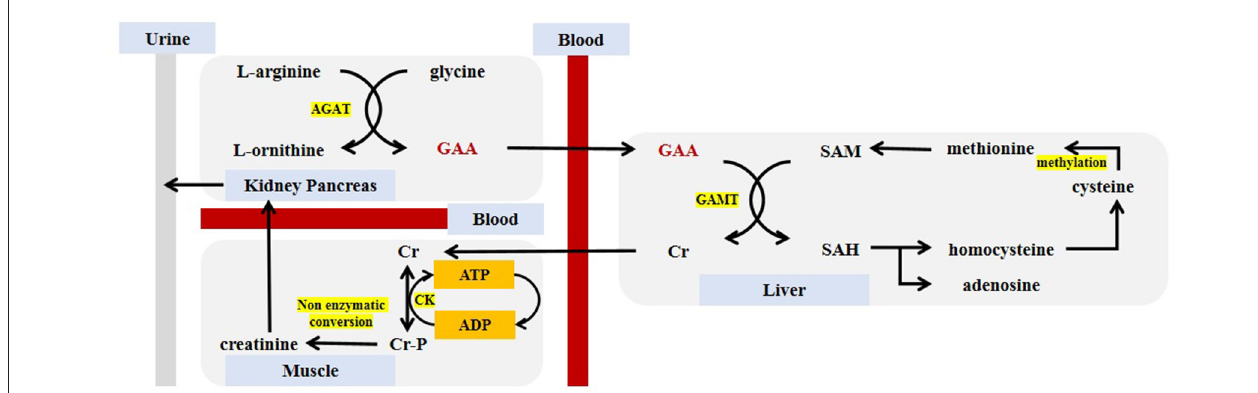
FIGURE 2 | Guanidinoacetic acid synthesis and metabolism. GAA, guanidinoacetic acid; Cr, creatine; Cr-P, phosphocreatine; SAM, S-adenosyl-methionine; SAH, S-adenosyl-homocysteine; AGAT, L-arginine:glycine amidinotransferase; GAMT, guanidinoacetate N-methyltransferase; CK, creatine kinase; ATP, adenosine triphosphate; ADP, adenosine